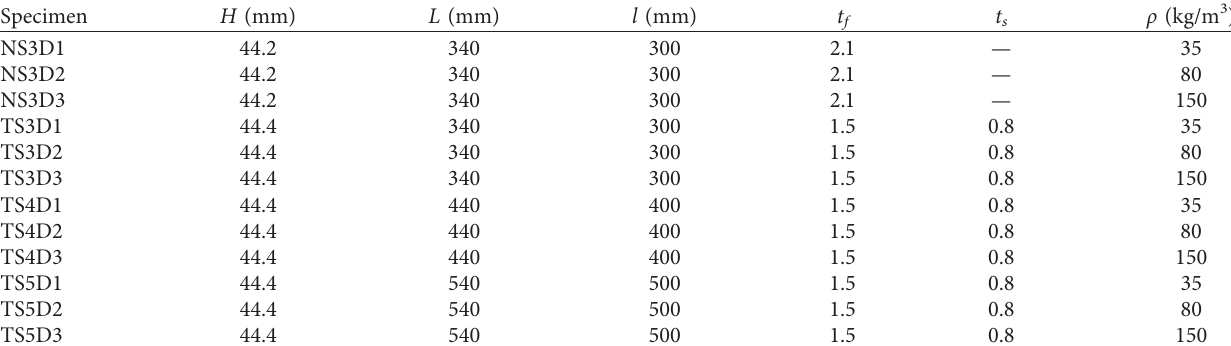
Figure 2: (a) Three-point bending test configuration according to ASTM C 393-62; (b) test specimen under loading. Table 3: Specimen parameters of ordinary sandwich beams and hybrid sandwich beams.